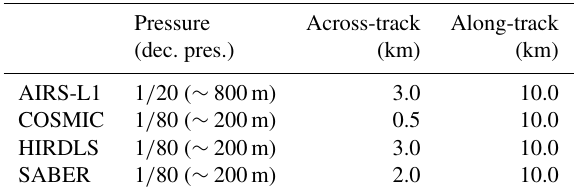
Table A1. Fine sampling point spacings used for each instrument Pressure Across-track Along-track (dec.